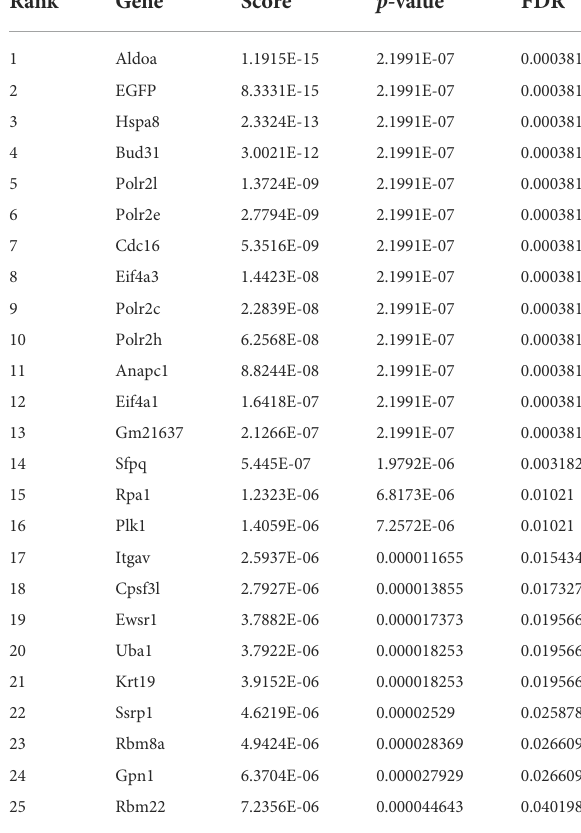
TABLE 2 Genes enriched in Both Up.